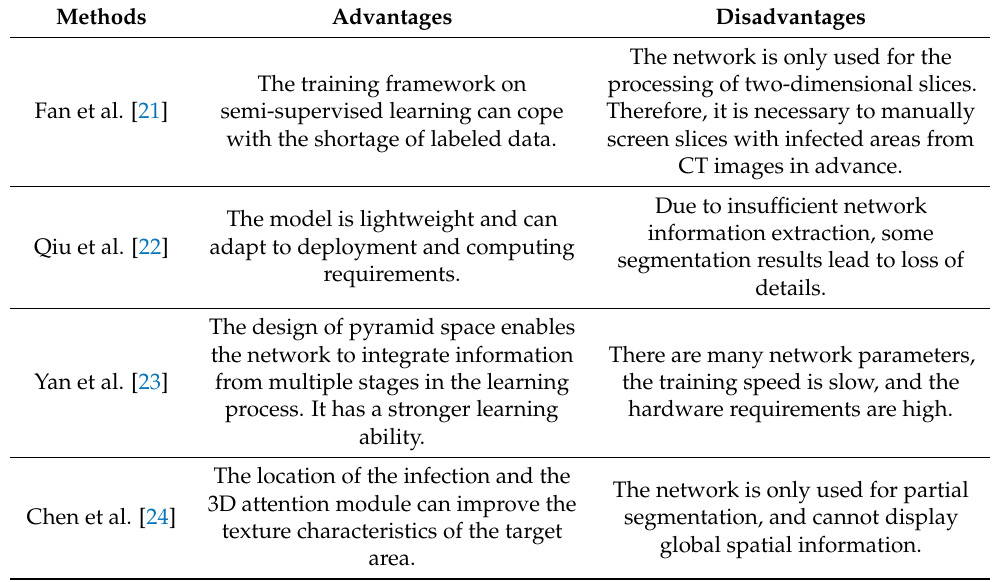
Table 1. Analysis of the Pros and Cons of Related Research.